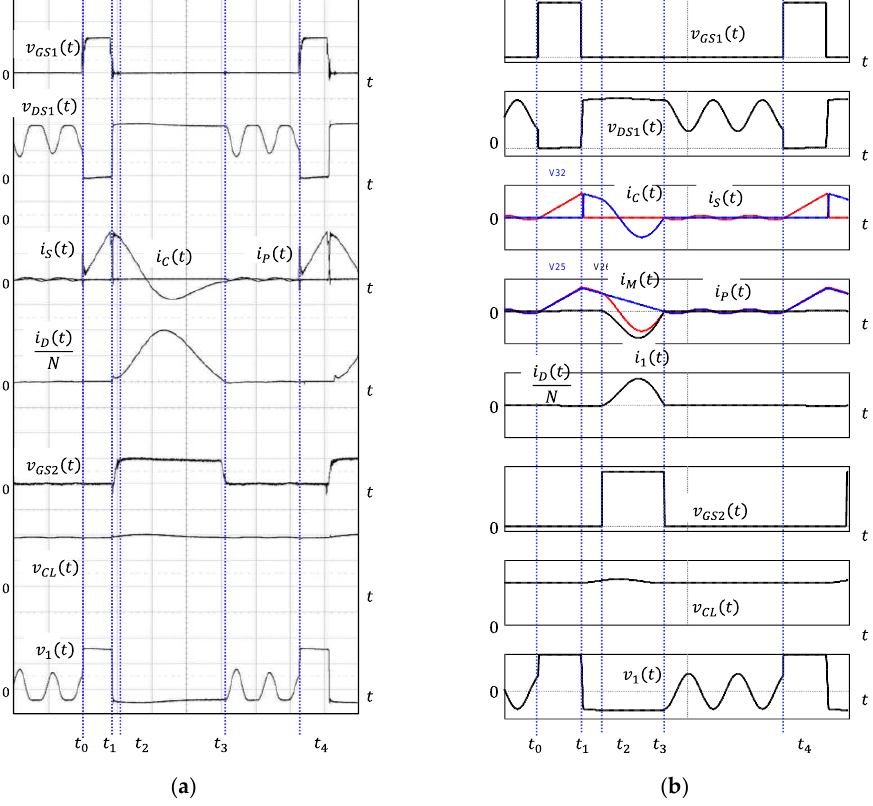
Figure 15. Comparison of operating waveforms of PSIM simulation and experimental circuit: ( a ) operating waveform of the experimental circuit; ( b ) operating waveform of PSIM simulation.